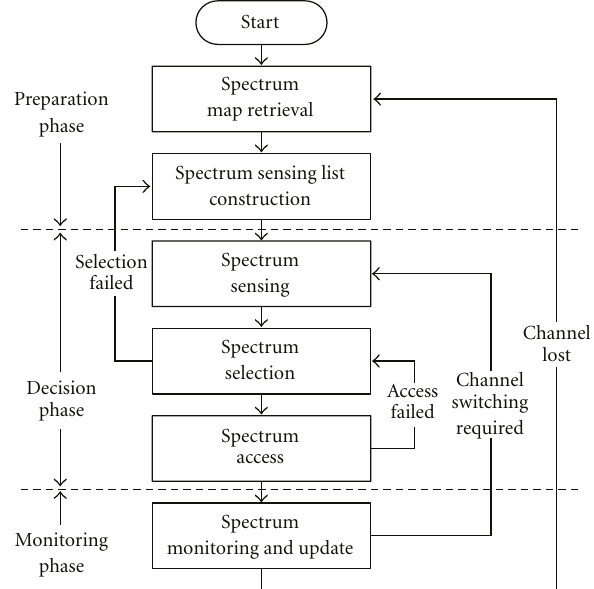
Figure 2: A general flow of a channel selection procedure with the extended spectrum